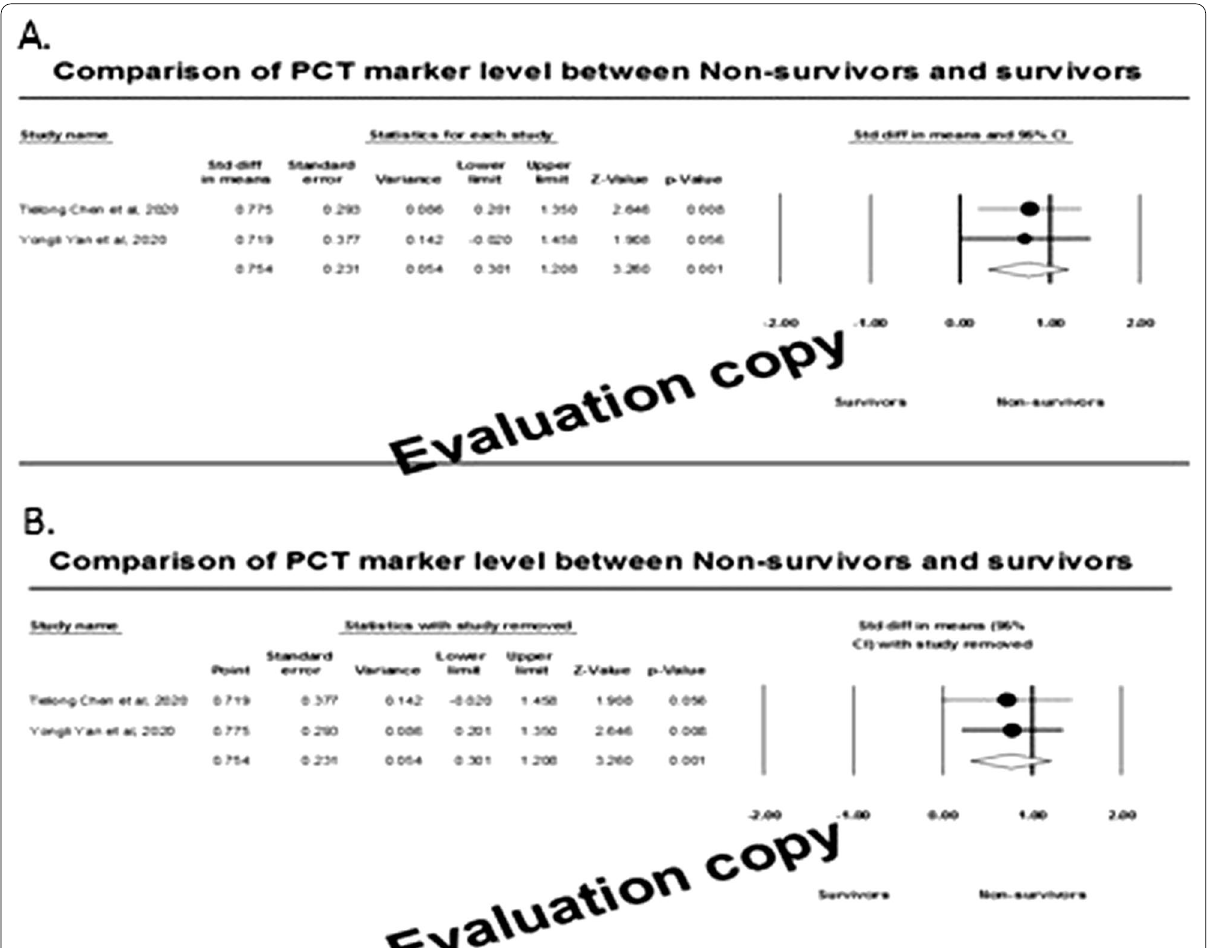
Fig. 11 Forest plot ( A ) and sensitivity analysis ( B ) of effect size among survivors and